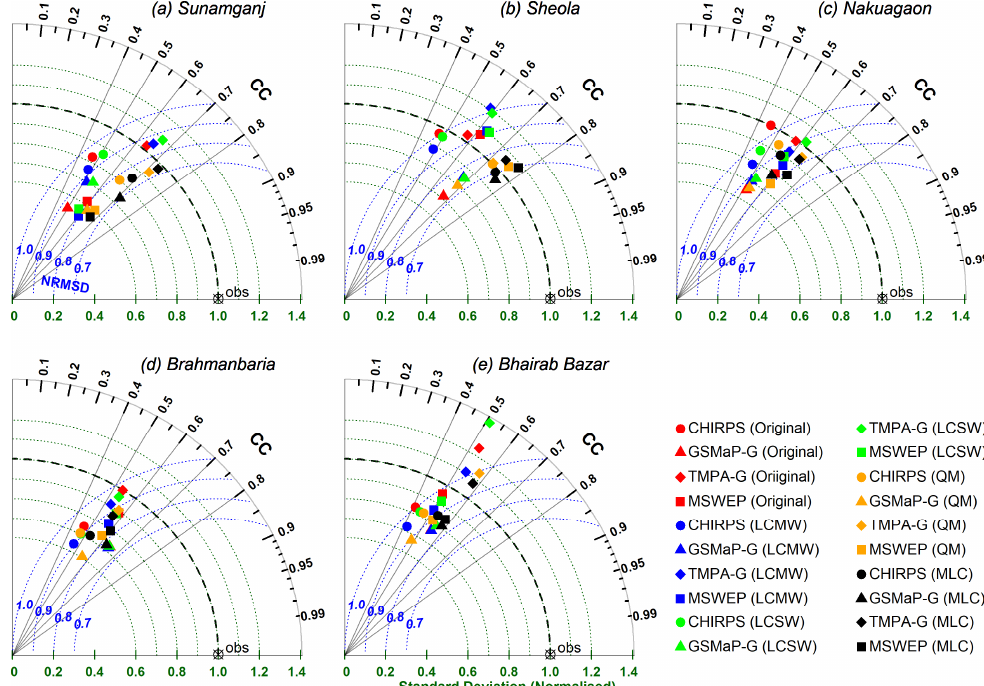
Figure 8. Taylor diagram illustrating statistical comparison between original, bias-corrected GSRP estimates and gauge rainfall (obs mark), as calculated for the wet seasons of 2009–2016 at five validation stations ( a – e ). The CCs are related to the azimuthal angle (grey lines), which denote a similarity in pattern between the satellite and gauge fields. NSDs (green contours) indicate the amount of variance between the satellites and the gauge time series, and is proportional to the radial distance from the origin. The NRMSD (blue contours) between the satellite products and the rain- gauge fields is proportional to the distance from the point on the x -axis identified as obs. For details, refer to Taylor [80].